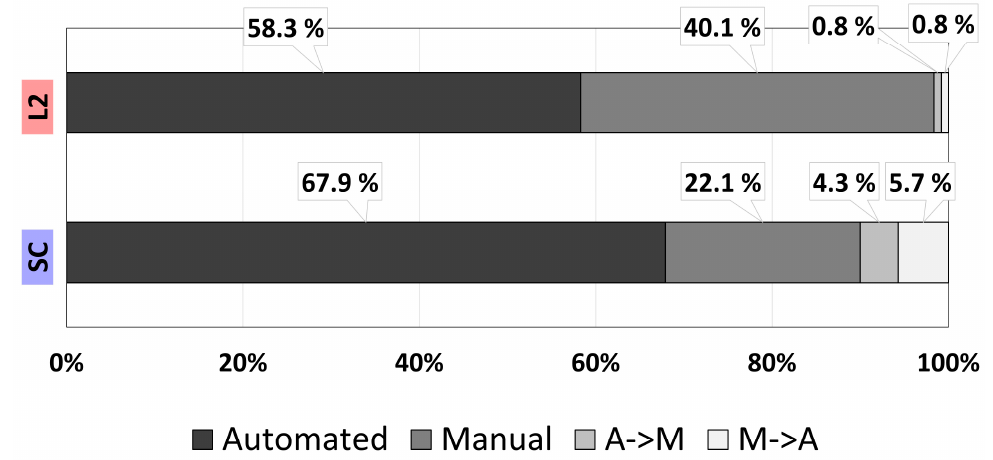
Figure 10. Percentage of time in each driving mode during the driving